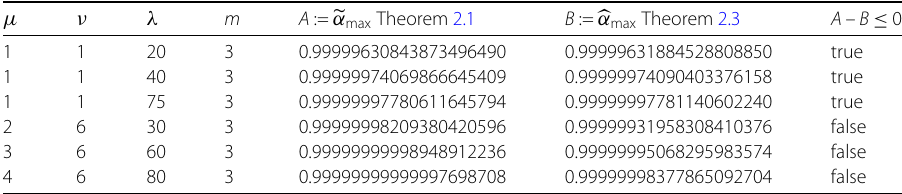
Table 1 Comparison of the order of starlikeness given by Theorems 2.1 and 2.3